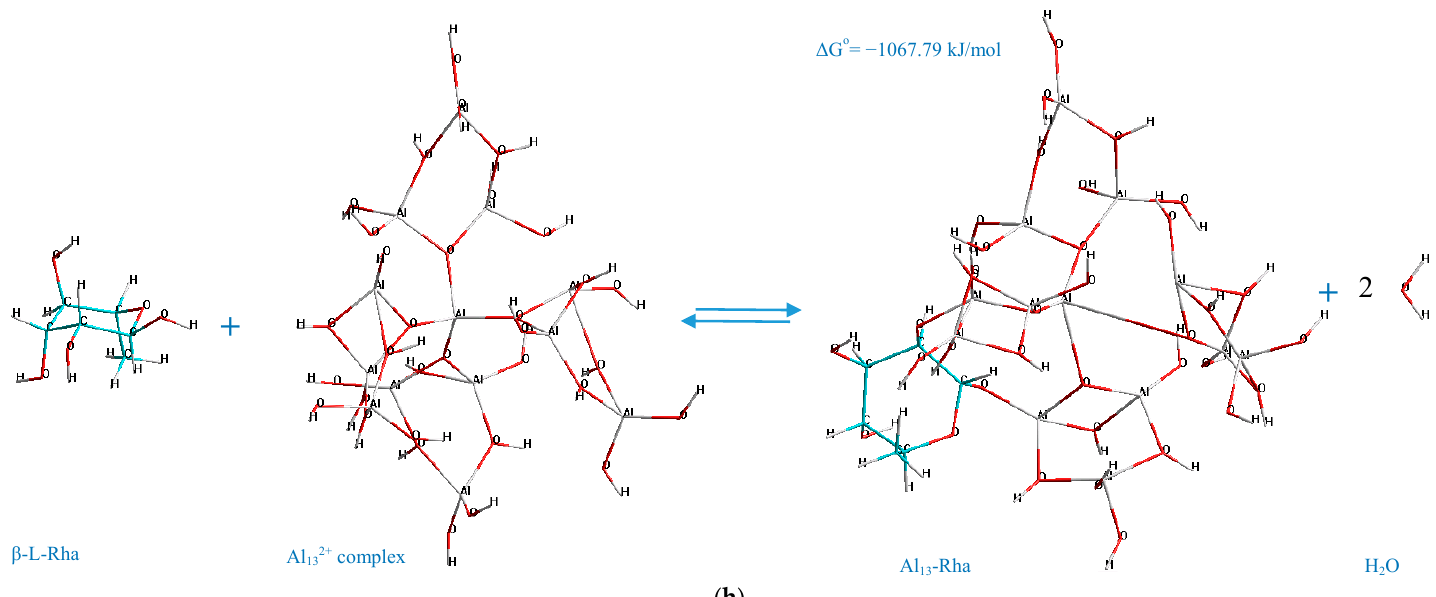
Figure 4. The determined mechanisms of formation of the most thermodynamically stable Al 13 -monosacharide complexes: ( a ) 4,6 GlcUA, Al 69,73; ( b ) 1,6 Man, Al 69,73; ( c ) 1,3 Ara, Al 69,62; ( d ) 1,6 Glc, Al 62,37; ( e ) 1,2 Fuc, Al 54,65; ( f ) 1,6 Gal, Al 54,65; ( g ) 4,6 GlcN; Al 69,73; ( h ) 1,2 Rha, Al 23,10.